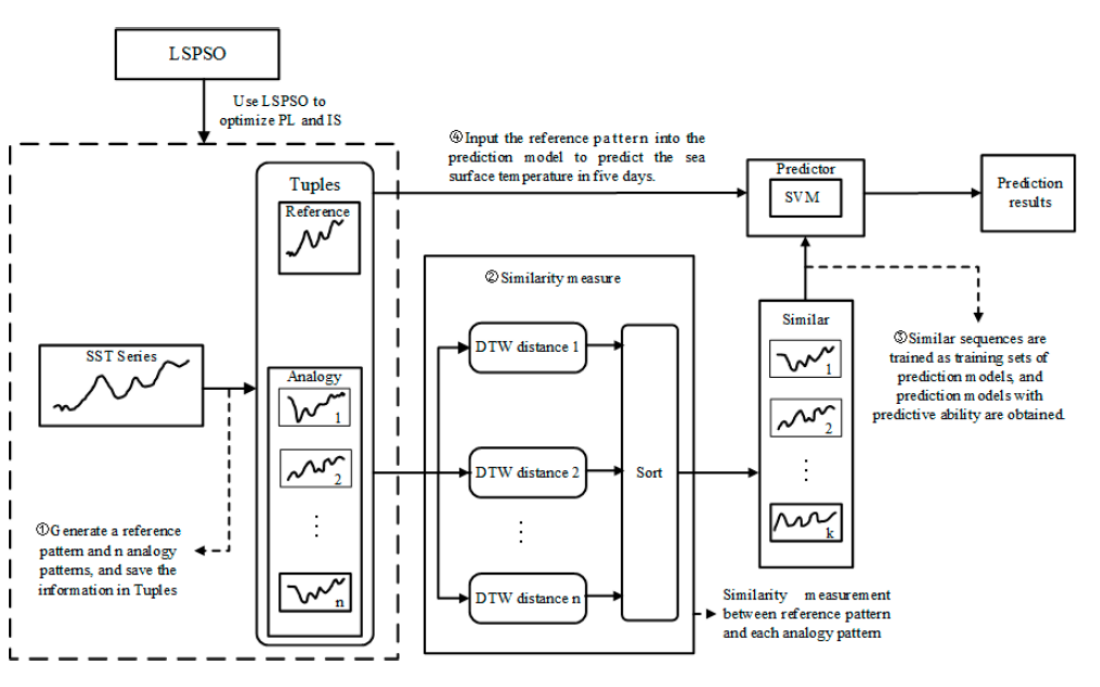
Figure 1. Flow chart of SSTP algorithm based on similarity measure.